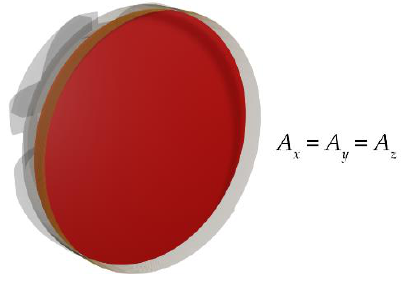
Figure 15. Cross-section area of the search coil magnetometer.